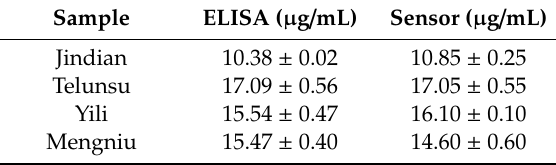
Table 1. Comparison of β -Lg detection in real samples using the electrochemical sensors and